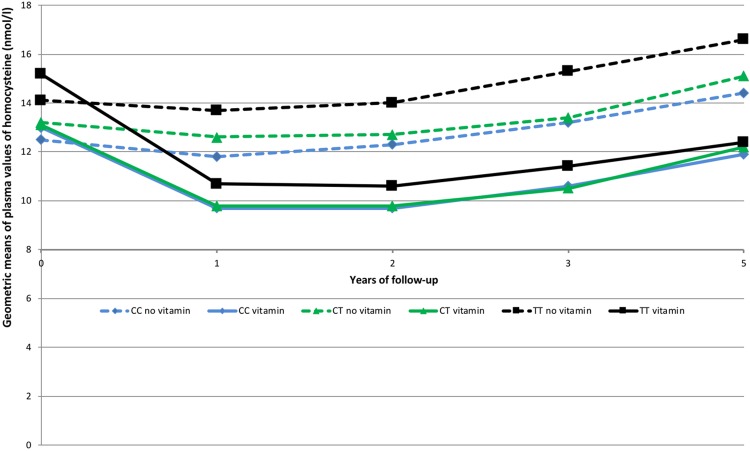
Evolution of the adjusted geometric mean plasma values of homocysteine from baseline through the 4.7 years of follow-up (with adjustment for sex, baseline plasma creatinine, type of prevalent CVD, vitamin B6, vitamin B12 and folate) among the three MTHFR genotypes and by supplementation group.Approximately half of patients not supplemented with B-vitamins and half of patients supplemented with B-vitamins were supplemented by n-3 fatty acids. The groups were merged because n-3 fatty acids supplementation did not interact with B-vitamin supplementation. The SU.FOL.OM3 trial (2003–2009).